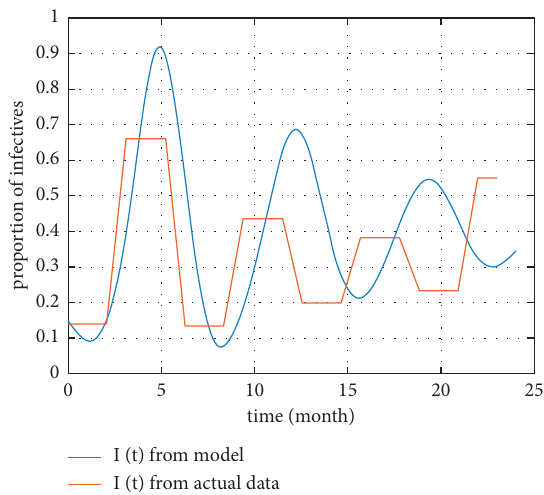
Figure 14: Proportion of the infective from March 2020 to January Table 7: Te relative error between the bin boundaries data and the model values.